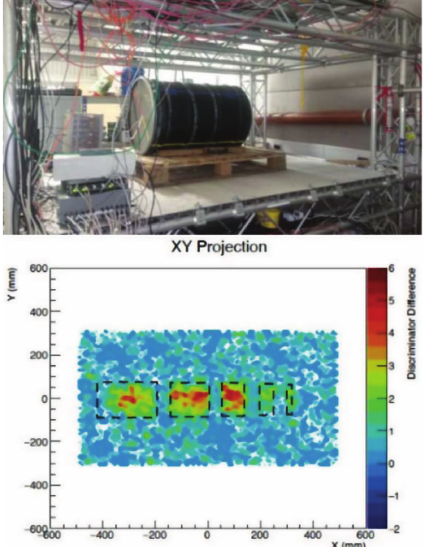
Fig. 3. Mock-up drum charcterization for the CHANCE project and reconstructed